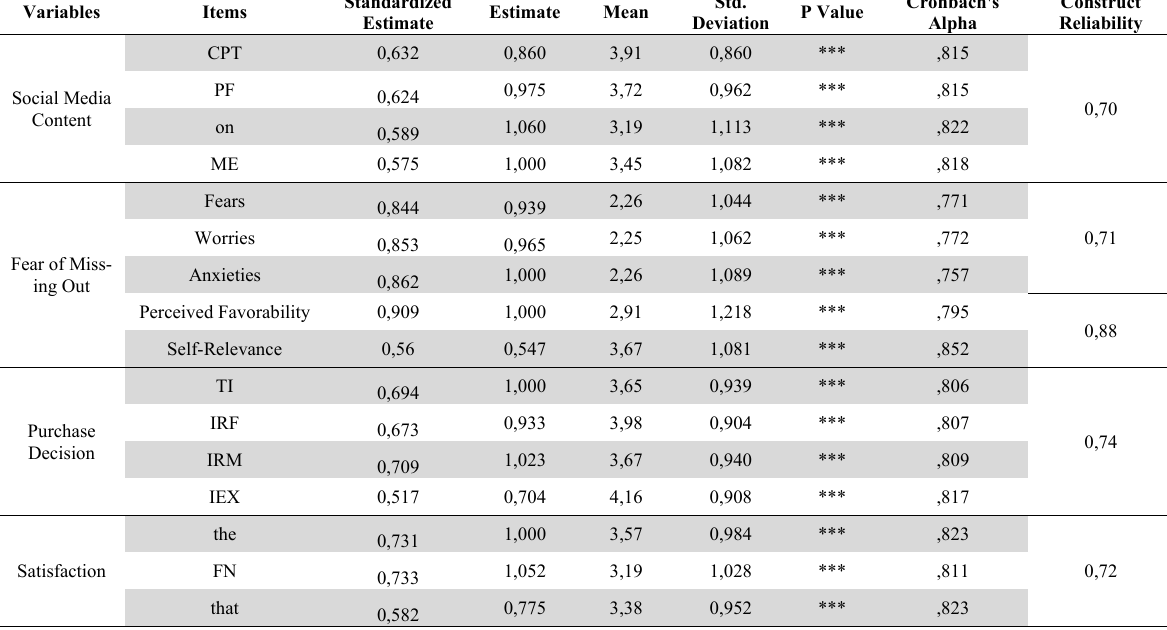
Goodness of Fit Indices